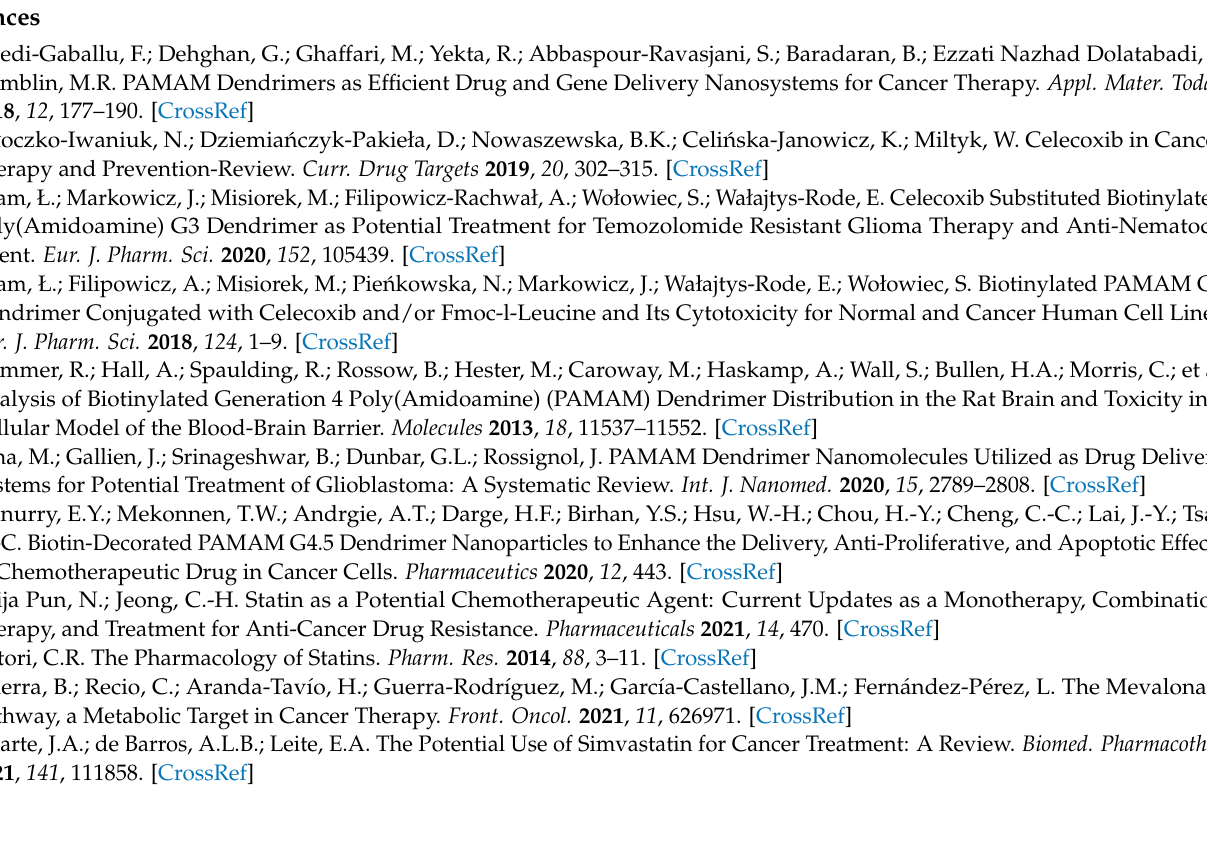
and en monitored by the 1 H NMR spectroscopy. Figure S2: COSY spectrum of G3 12S in DMSO-d 6 . Figure S3: COSY spectrum of simvastatin in DMSO-d 6 . Figure S4: COSY spectrum of G3 2B4S12gl in DMSO-d 6 . Figure S5: Size of conjugates by DLS. Figure S6: Zeta potential of conjugates. Figure S7: Cytotoxicity of G3 2B14gl carrier for BJ, SCC-15, and U-118 MG cells. Table S1: The 1 H and 13 C NMR chemical shifts of simvastatin (S); celecoxib (C); and G3 12S , G3 2B4S14gl , G3 2B2C4S12gl , and G3 2B6C8gl conjugates in DMSO-d 6